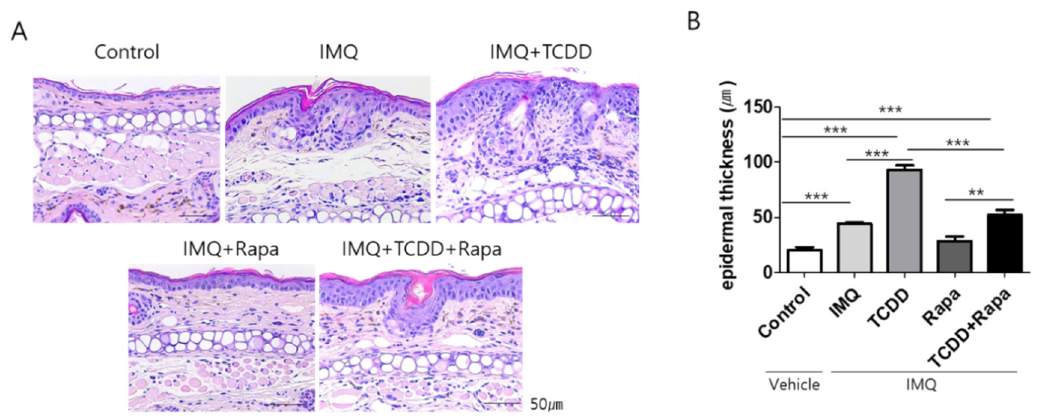
Figure 3. Histological changes after treatment with TCDD, rapamycin, or both in an IMQ-induced psoriasis mouse model. ( A ) Hematoxylin and eosin (H&E) staining of representative images from each group (dorsal skin). Bars represent 50 μ m. ( B ) Evaluation of epidermal thickness in dorsal skin. The epidermal thickness was measured from the bottom of the rete ridge to the bottom of the stratum corneum; the mean was calculated from the measurements in four fields at × 100 magnification. Data represent mean ± standard deviation (SD). Statistical significance was determined by one-way repeated measures analysis of variance (ANOVA) with Dunnett’s test. ** p < 0.01; *** p < 0.001. IMQ: imiquimod, Rapa: rapamycin.